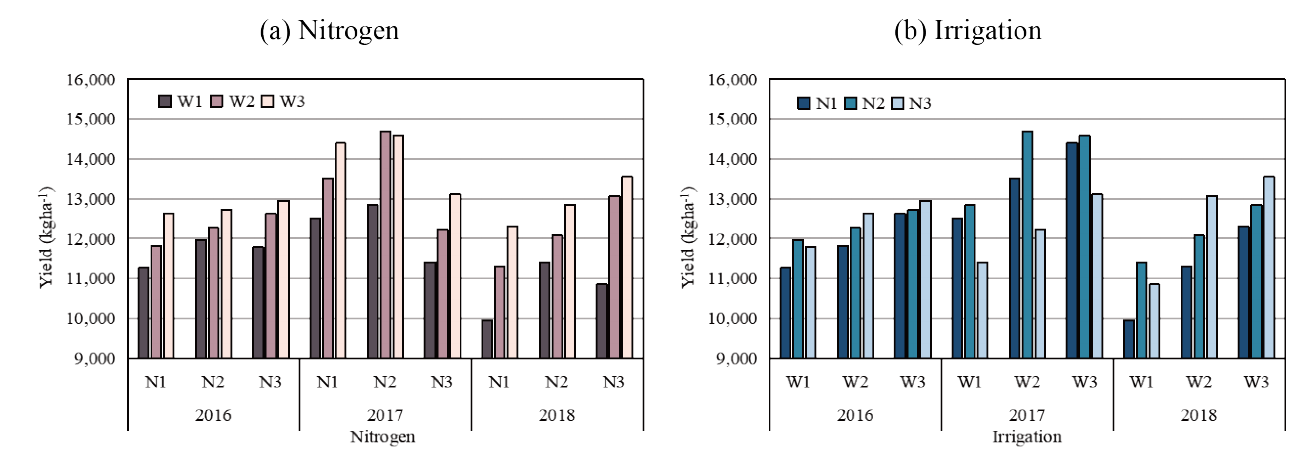
Figure 5. Maize yield under different water and nitrogen treatments. ( a ) Effect of different nitrogen inputs on yield. ( b ) Effect of different irrigation on yield. Table 3. Effects of different water and nitrogen treatments on maize yield and WUE.